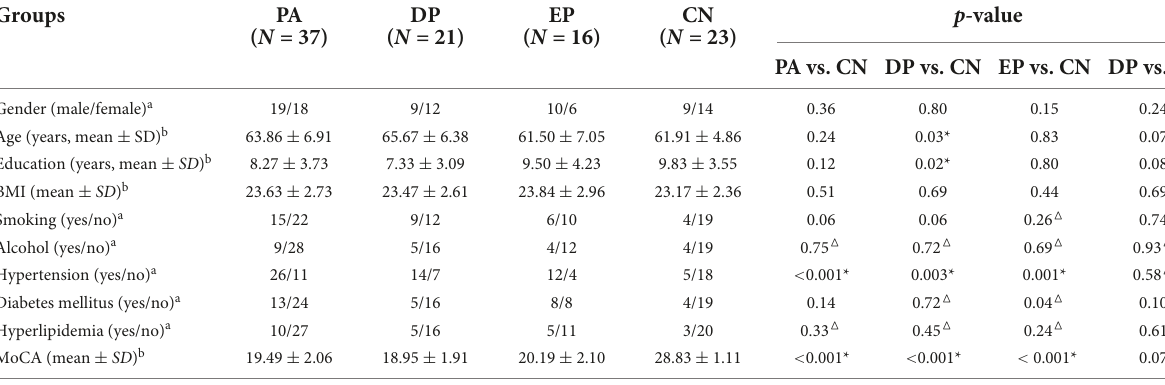
TABLE 1 Demographic and clinical characteristics in the PA group, DP group, EP group and CN group. Groups PA